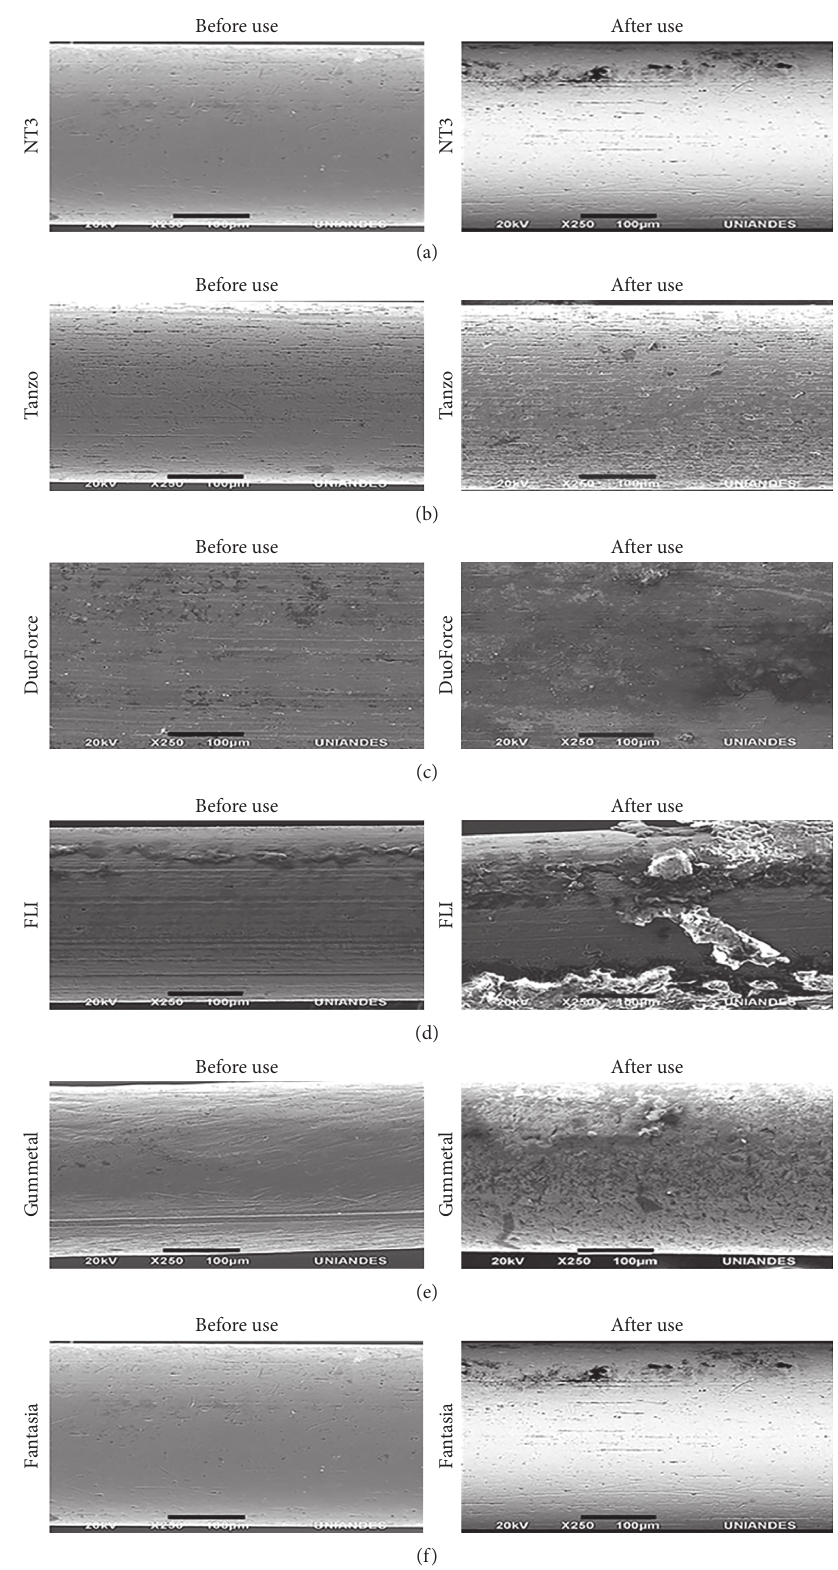
Figure 3: Scanning microscopy of wires examined: electron microscopy images of NT3 ® (a), Tanzo ® (b), DuoForce ® (c), FLI ® (d), Gummetal ® (e), and Fantasia ® (f) wires before and after use in the mouth. Bar: 100mm; original magnification: